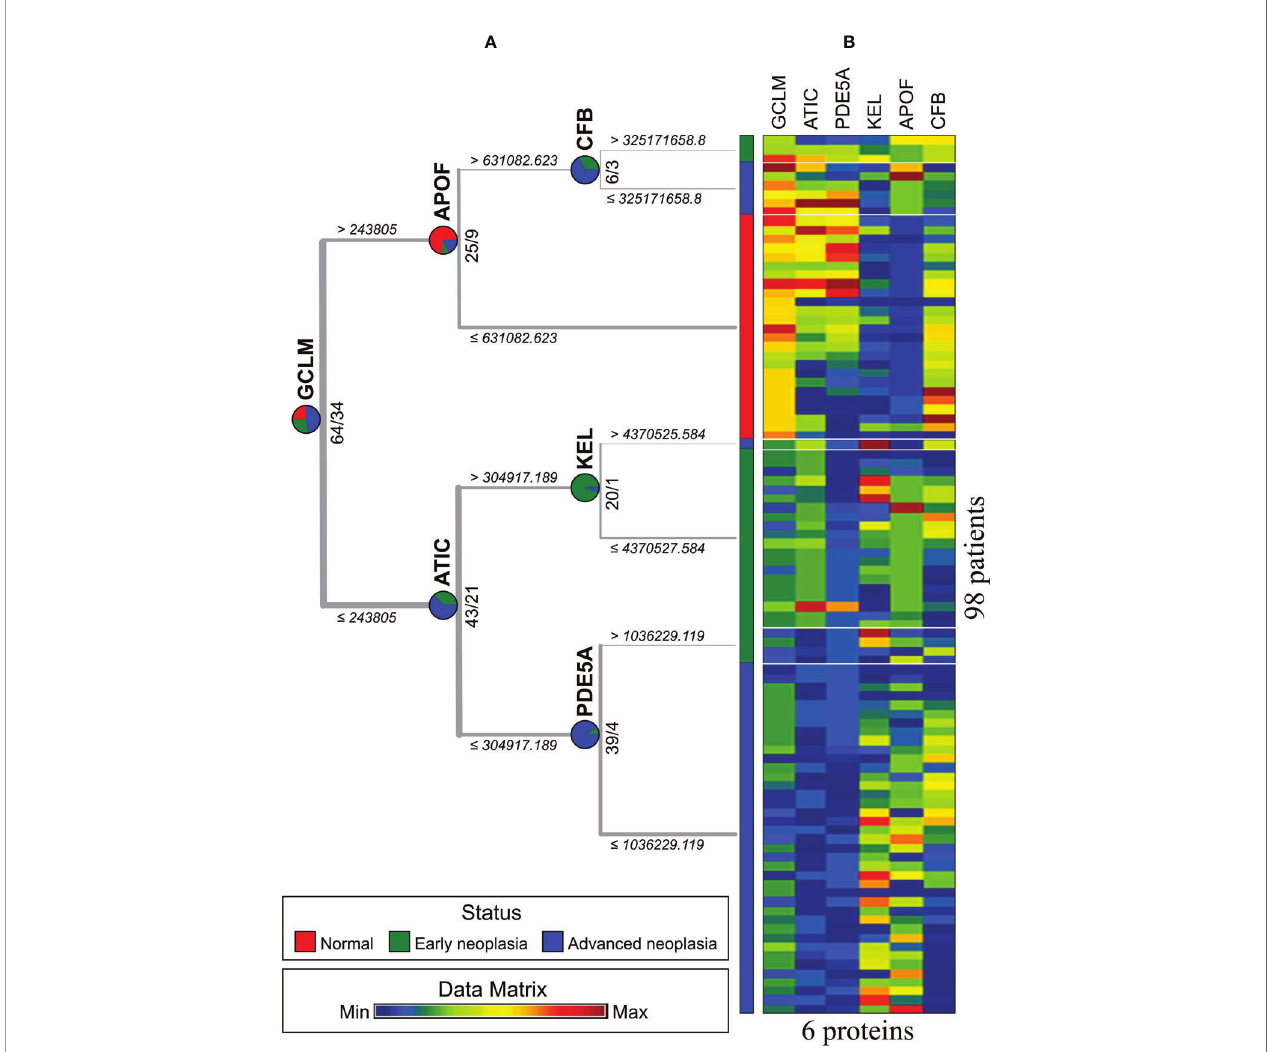
FIGURE 4 | Three status types were classi fi ed by an exosome protein data matrix for 98 patients. (A) The result of the decision tree. (B) Matrix visualization based on decision tree